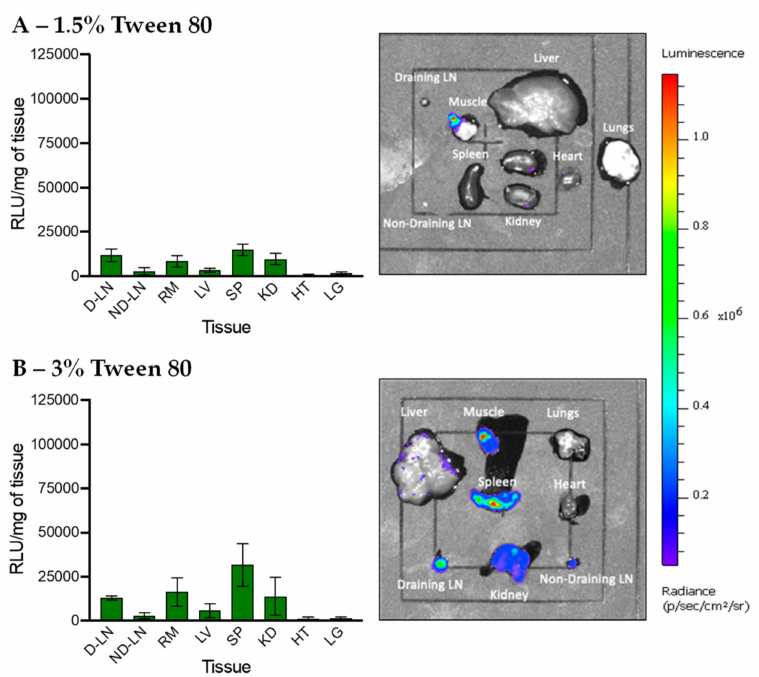
Figure 6. In vivo transfection of LNPs stabilized by Tween 80 at ( A ) 1.5% and ( B ) 3%. The graphs on the left show the luminescence relative light unit (RLU) of homogenized tissues recorded by the plate reader and the right IVIS images show the luminescence of whole tissues. The abbreviations of tissues are draining lymph node (D-LN), non-draining lymph node (ND-LN), right muscle (RM), liver (LV), spleen (SP), kidney (KD), heart (HT) and lungs